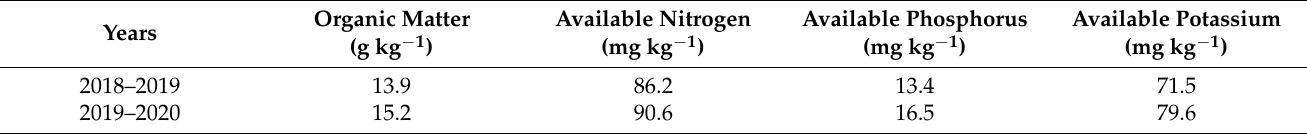
Table 1. Presentation of the chemical characteristics of the soil in